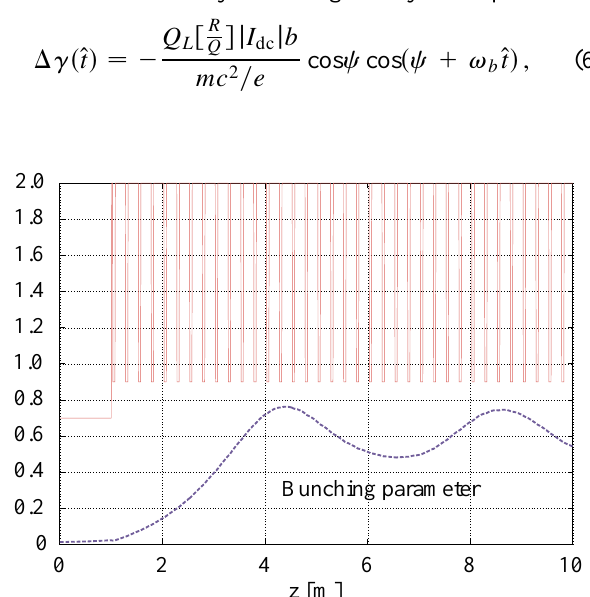
FIG. 6. (Color) Bunching parameter variation along beam line (dashed blue line). The beam pipe wall radius (in cm) and positions of the rf cavities are indicated by the solid red line. The entrance to the SL4 klystron corresponds to z (cid:1) 0